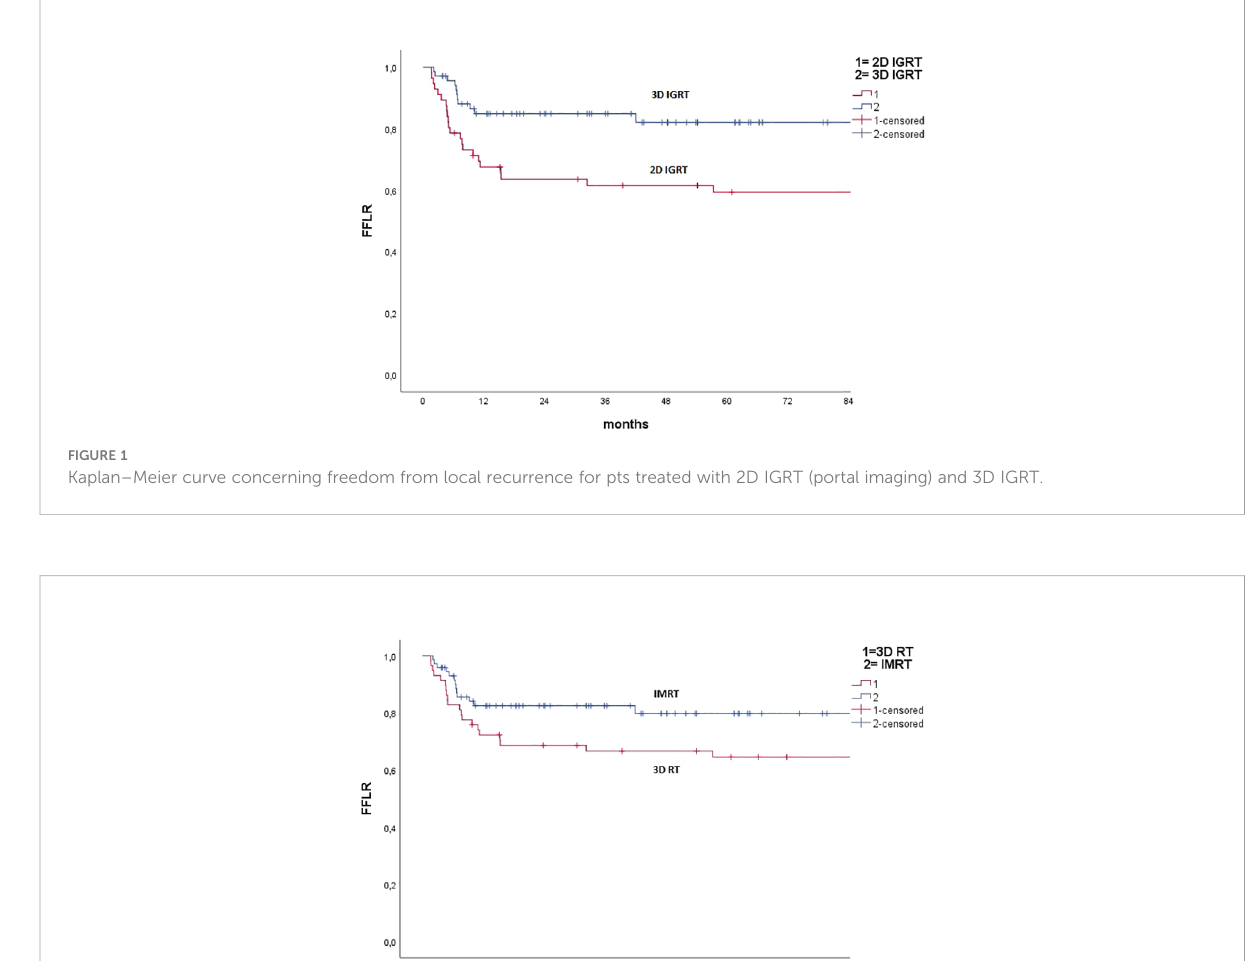
Figure 3, the relapses are on the left side of both panes. Since both panes have SI as a horizontal axis, it is con fi rmed that a lower SI correlates with a higher risk of relapse. In the left pane, the vertical axis is LAHGLE, and relapses are in the upper part. Higher LAHGLE has a positive correlation with relapse. In the right pane, GTV is on the vertical axis and, with similar reasoning, we can conclude that a smaller GTV volume correlates with relapse. The risk of relapse depends on a combination of the three parameters since the cut-off between relapse and non-relapse is never a horizontal or vertical line.